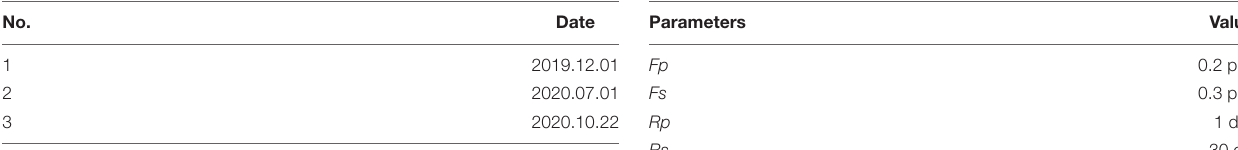
TABLE 1 | The monitoring frequencies and times. TABLE 2 | The parameters of the Butterworth low-pass filter.